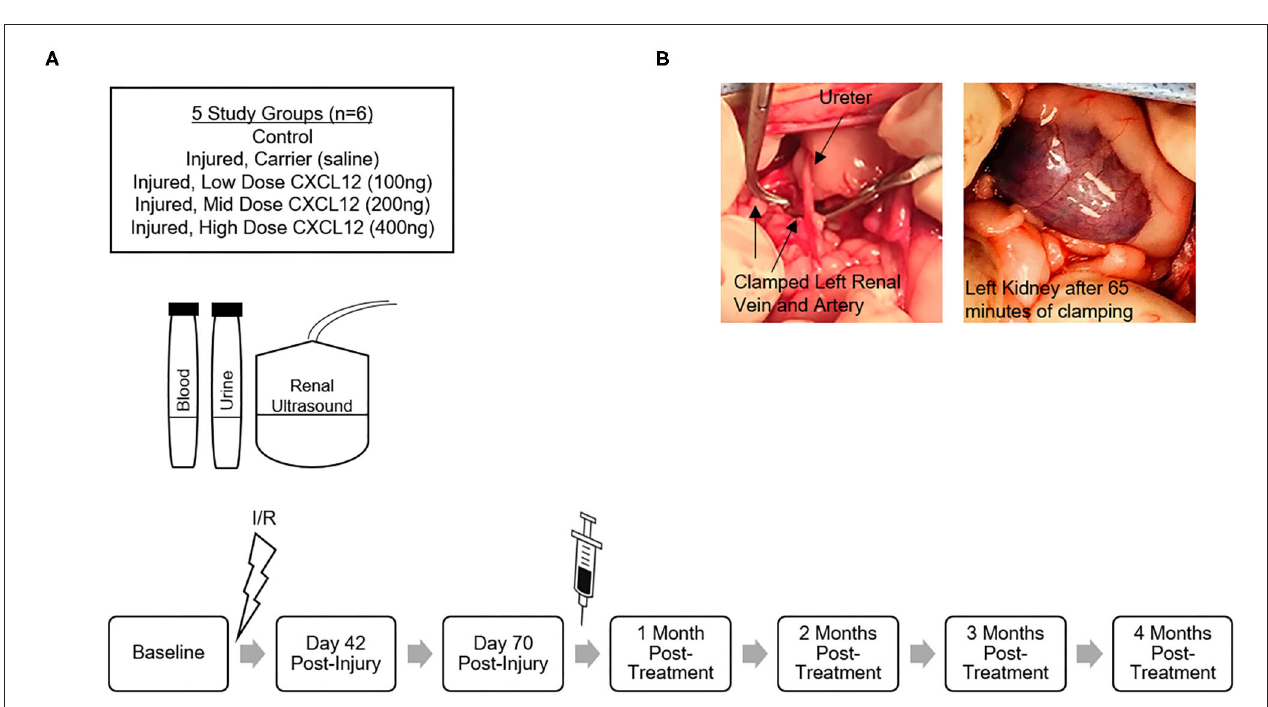
FIGURE 2 | (A) Schematic of pre-clinical study design and timeline using 5 groups of cats to test the effects of intra-renal injection of 100, 200, or 400 ng ( n = 6/dose) of CXCL12, or sterile saline carrier ( n = 6), administered 70 days after I/R-induced renal fibrosis. Six cats in a control group were uninjured and not injected. Baseline blood/urine renal function tests and ultrasounds were performed at the time of I/R Injury, Day 42, Day 70 (Treatment injection), and then monthly for 4 months post-injection. (B) Intraoperative images during I/R injury surgery with vascular clamps occluding left renal artery and left renal vein and purple discoloration of the kidney. Clamps remained in place for 65min and then were released restoring renal blood flow that was confirmed using a Doppler probe to detect renal artery pulsation. using a Doppler probe to detect pulsation of the renal artery. discoloration of the kidney was observed as visual evidence of The incision was closed in three layers, cats were recovered hypoxia ( Figure 2B ). Clamps remained in place for 65 min and in their cages, and appropriate analgesics (e.g., then were released restoring renal blood flow that was confirmed